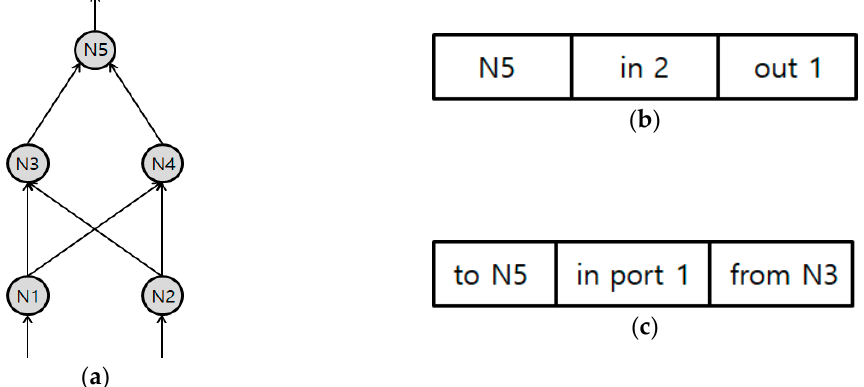
Figure 3. Example of artificial neural network (ANN) topology and chromosomes: ( a ) Example of ANN topology; ( b ) example of neuron information ANN topology; and ( c ) example of linking information ANN topology.